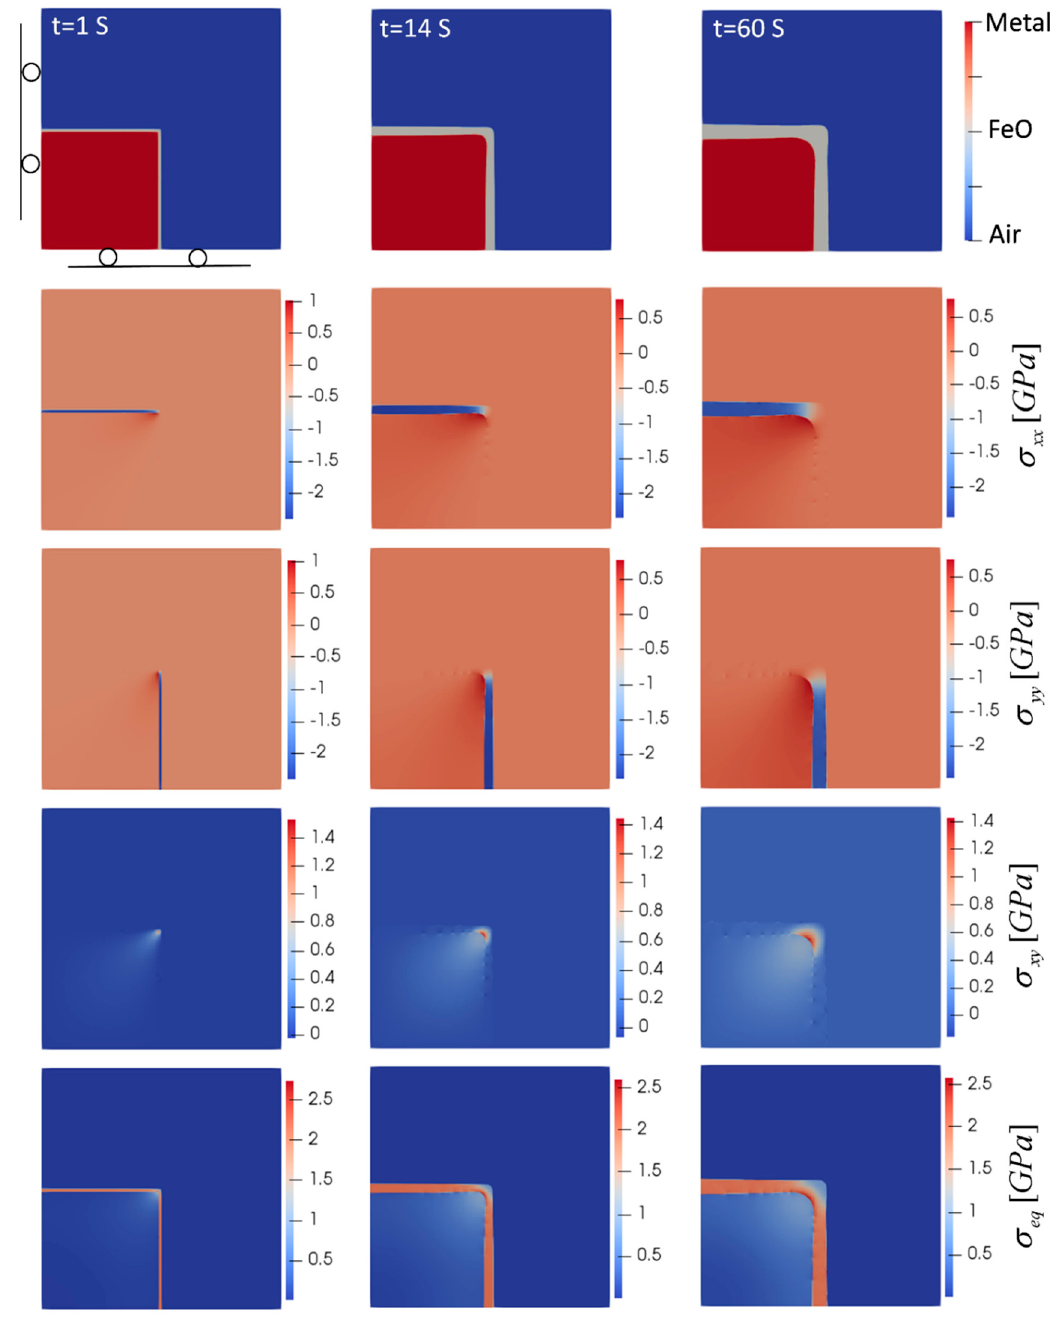
Figure 4. Oxide layer growth and evolution of induced stresses for the oxidation of a sharp corner (T = 850 °C). Domain size is 0.5 mm × 0.5